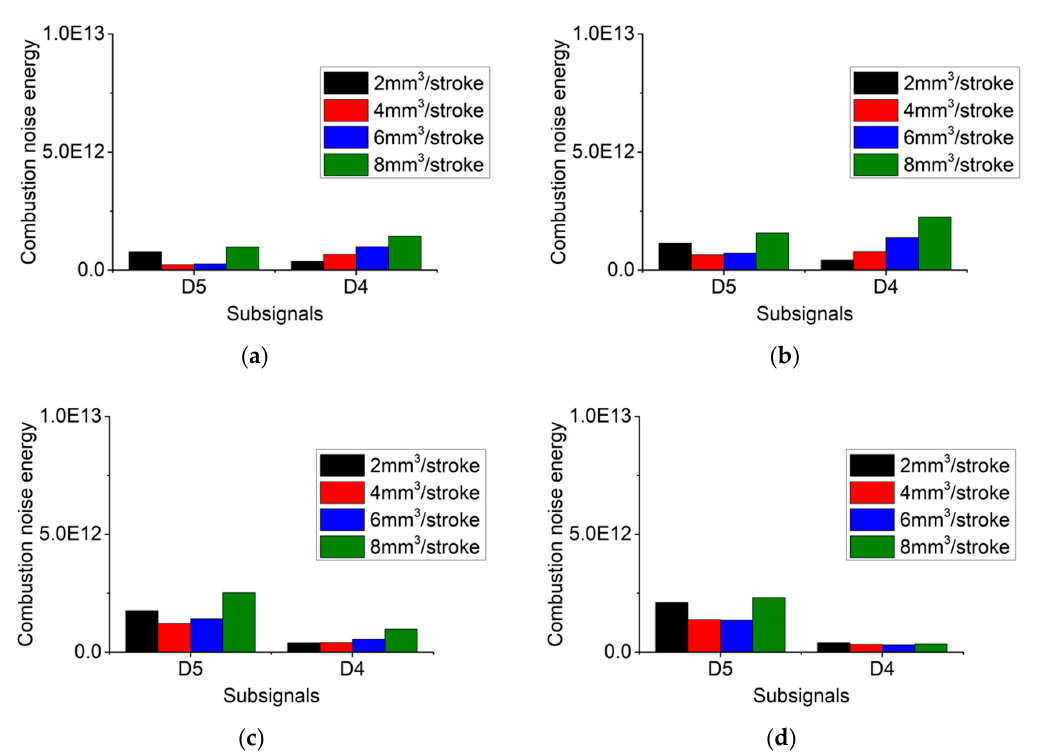
Figure 7. Pilot combustion noise energy of D4 and D5. ( a ) Pilot injection timing = − 9° ATDC; ( b ) pilot injection timing = − 14° ATDC; ( c ) pilot injection timing = − 19° ATDC; ( d ) pilot injection timing = − 24° ATDC.